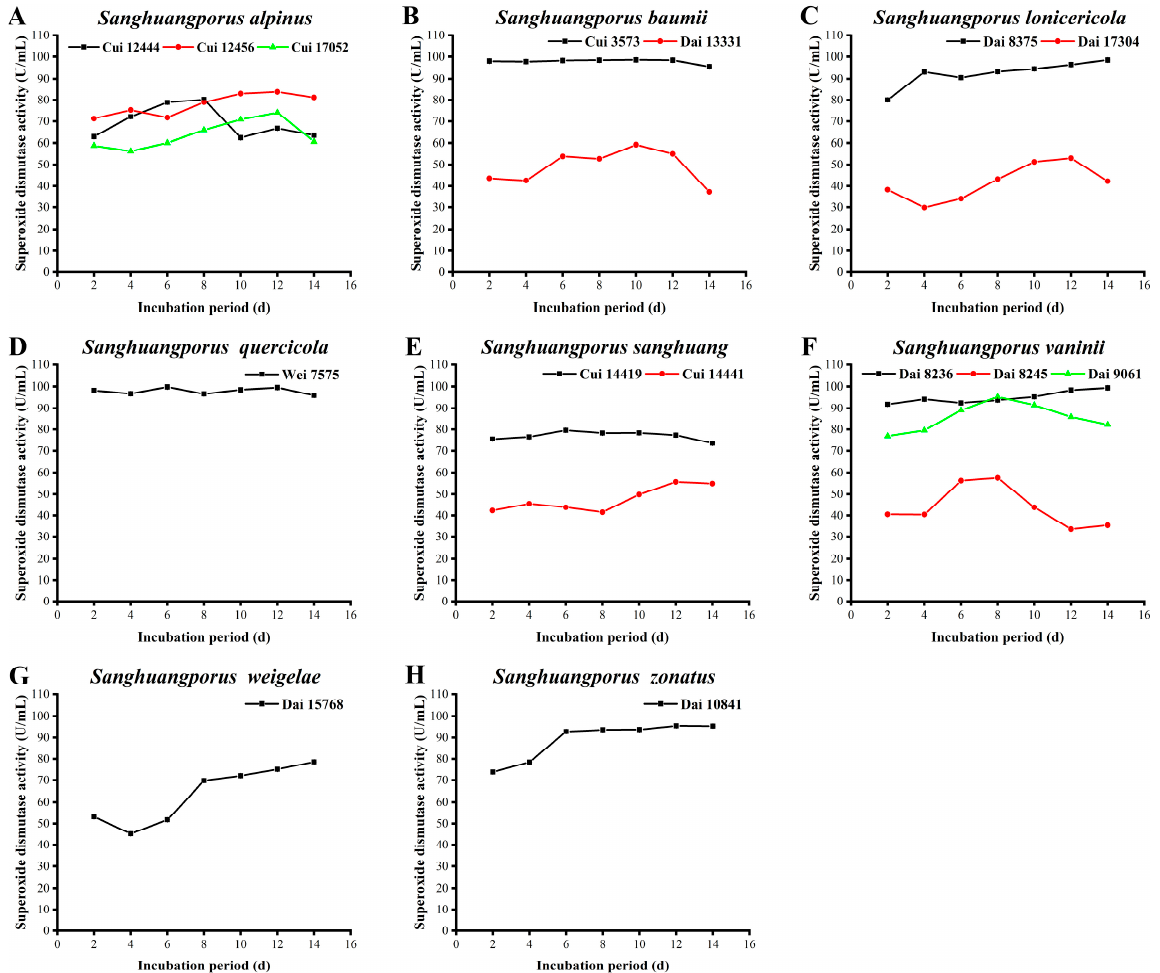
Figure 11. Variations in superoxide dismutase activities during submerged fermentation of 15 wild strains from 8 species of Sanghuangporus . ( A ) Sanghuangporus alpinus Cui 12444, Cui 12456, and Cui